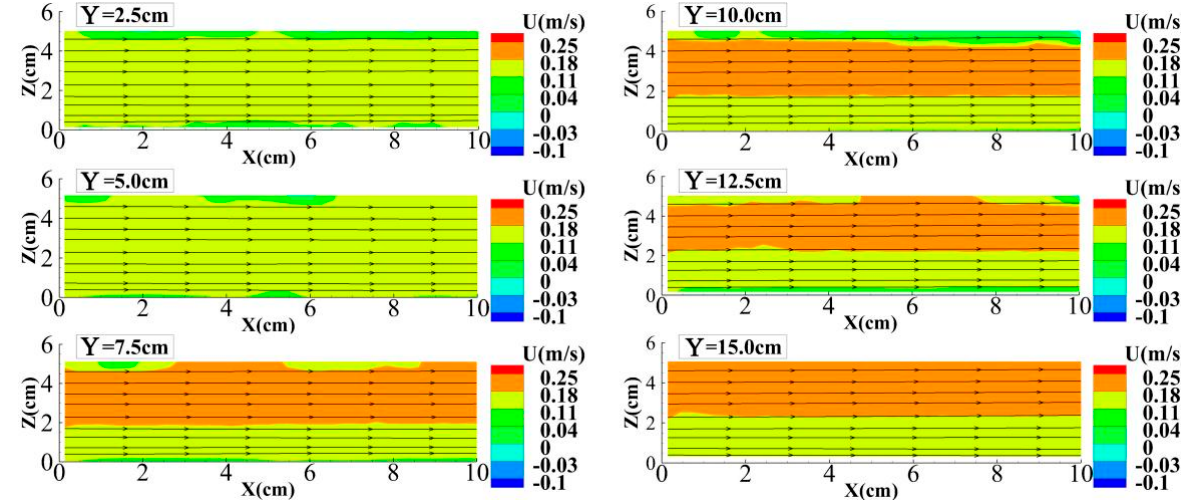
Figure 4. Distributions of the absolute velocity at longitudinal sections in Case 1.